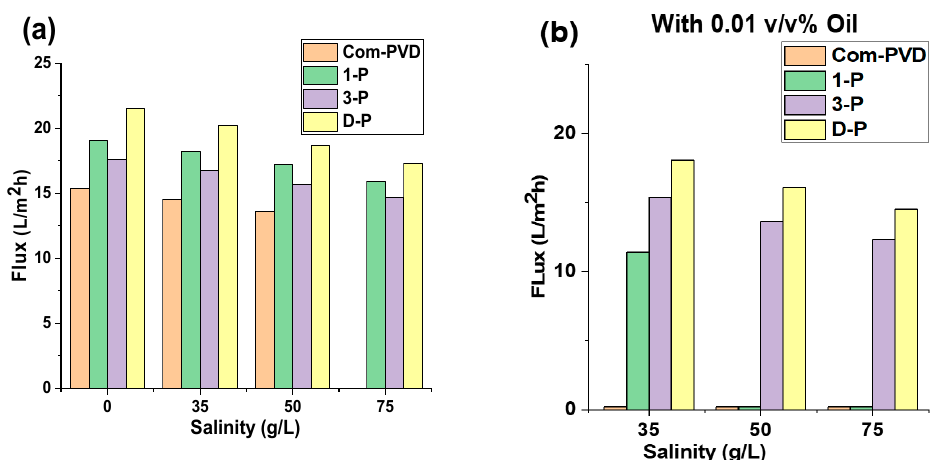
Figure 6. Effect of salinity on the performance of the different membranes in this study. Flux performance ( a ) without oil contaminant in feed, and ( b ) with 0.01 v/v% mineral oil in feed solution.